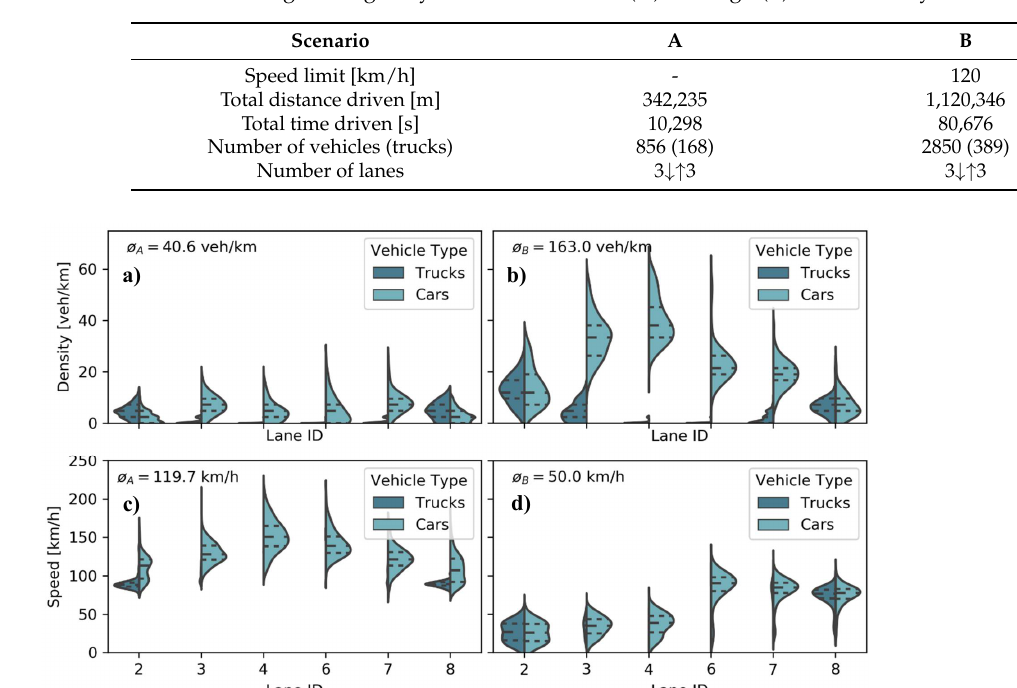
Table 1. Investigated highway scenarios with low (A) and high (B) traffic density.